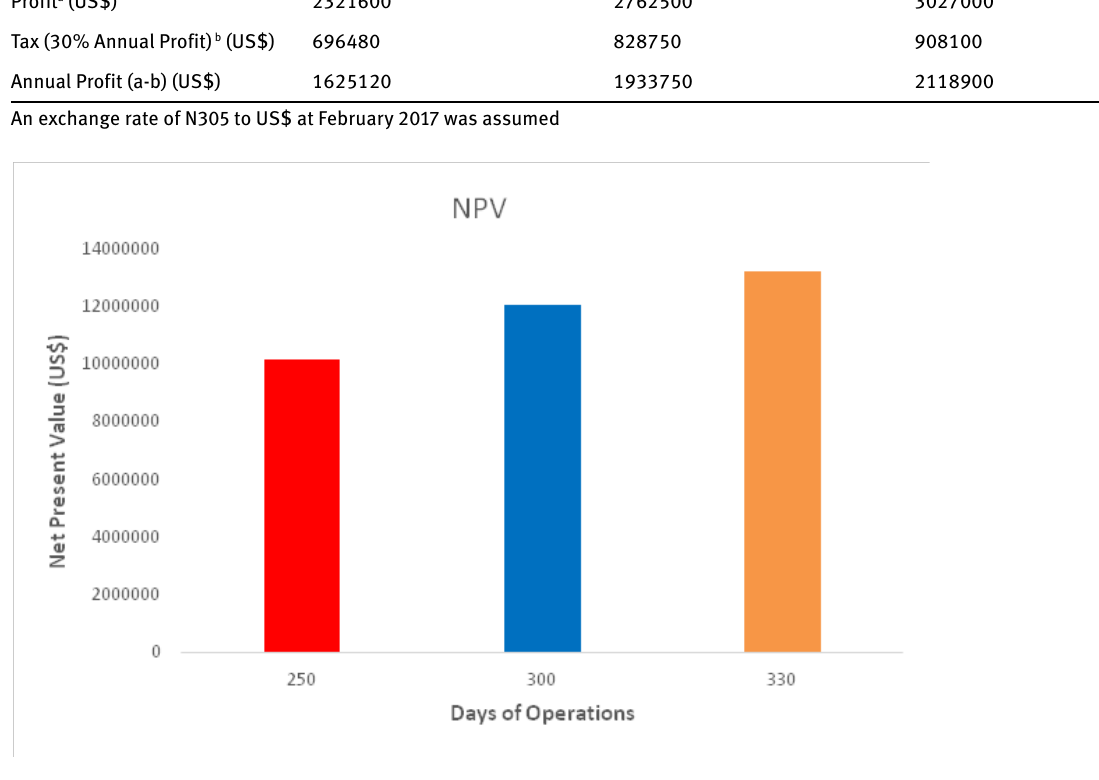
Fig 2. Net present value at different operation